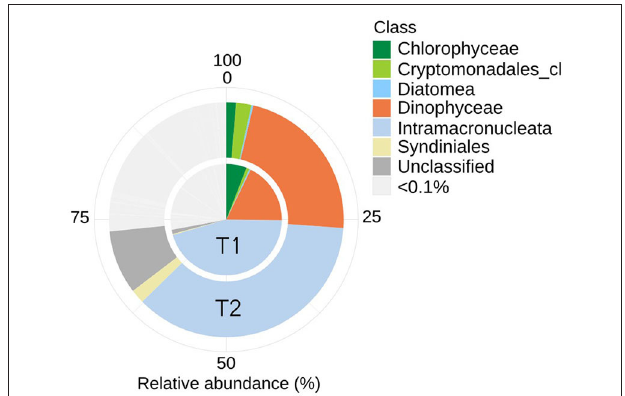
FIGURE 2 | Eukaryotic community composition (18S rRNA) including ASVs with an average (of triplicates) relative abundance > 0.1% per timepoint (T1 or T2). Assigned taxonomy at class level. Intramacronucleata is a subphylum of ciliates and consists of heterotrophic